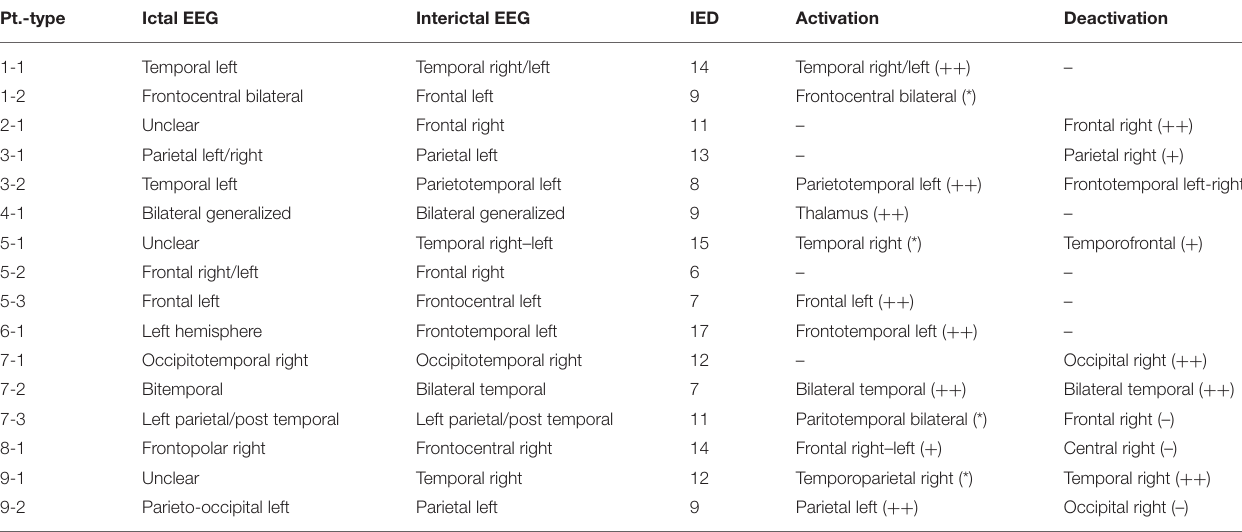
TABLE 1 | Summary of IED studies which indicated a significant component-related BOLD response to consensus IEDs (22).